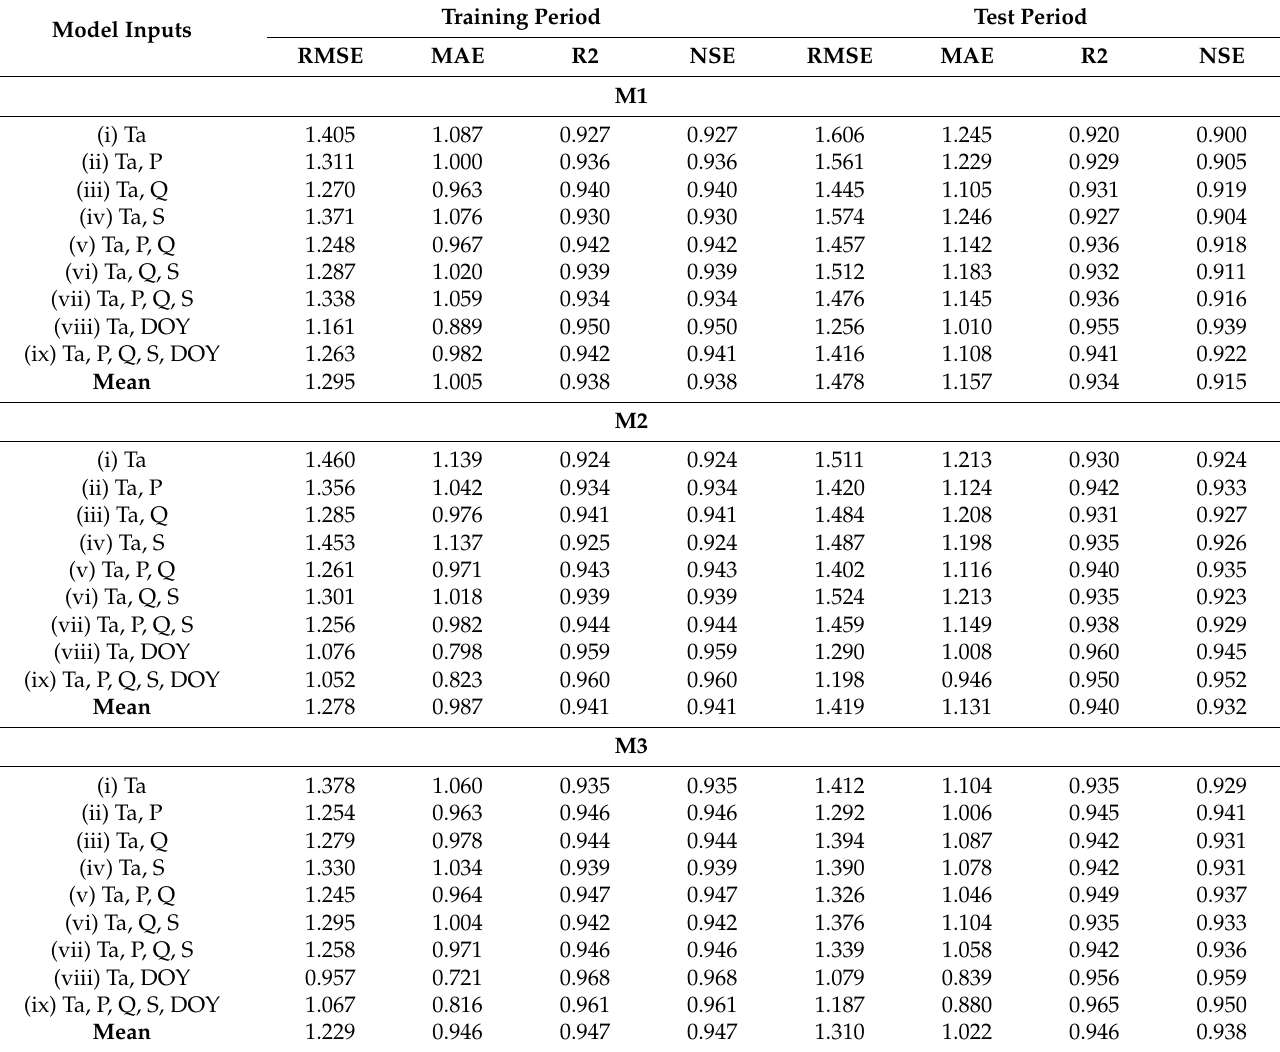
Table 9. Training and test statistics of the models for water temperature